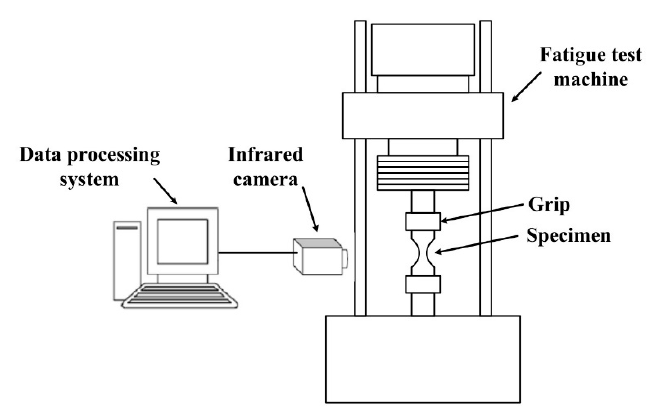
Figure 2. Schematic diagram of the experimental setup.